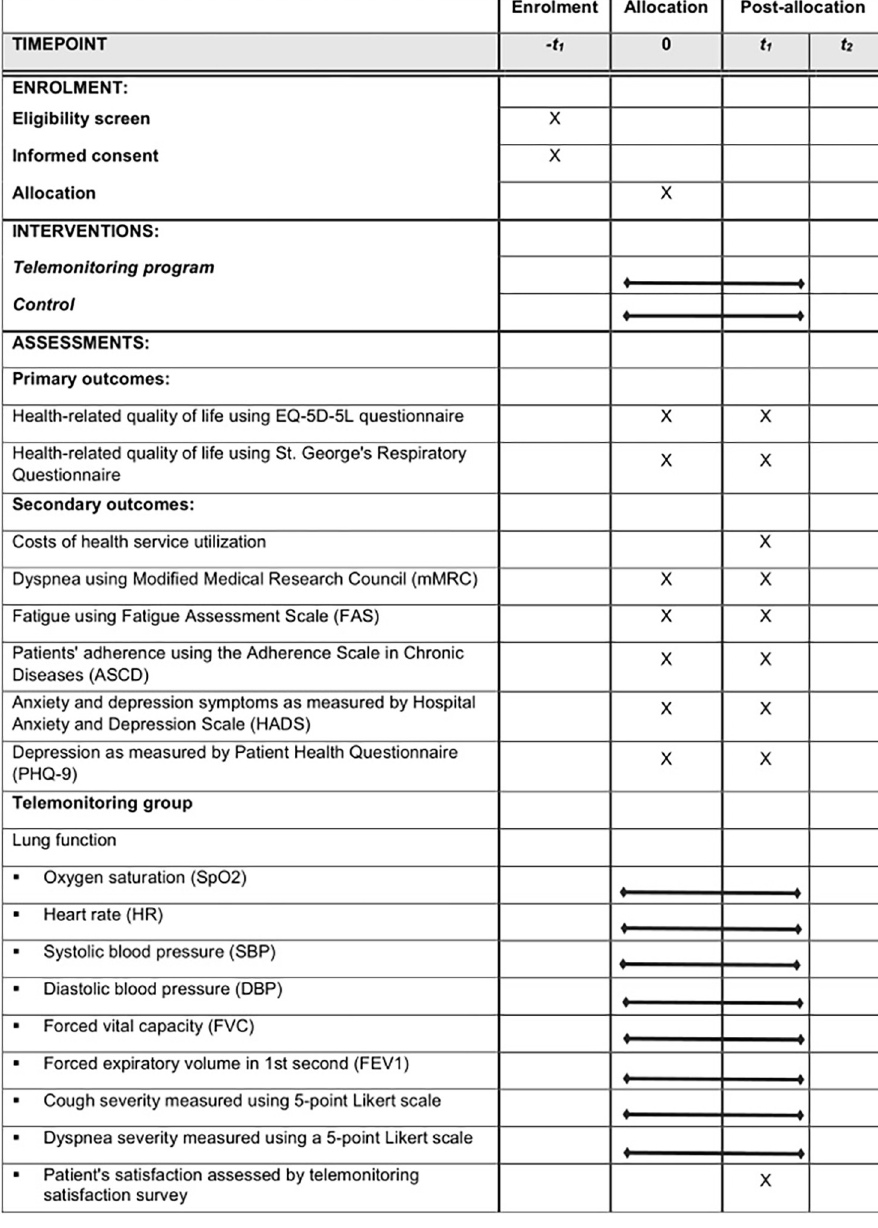
Fig 1. SPIRIT schedule of enrolment, interventions, and